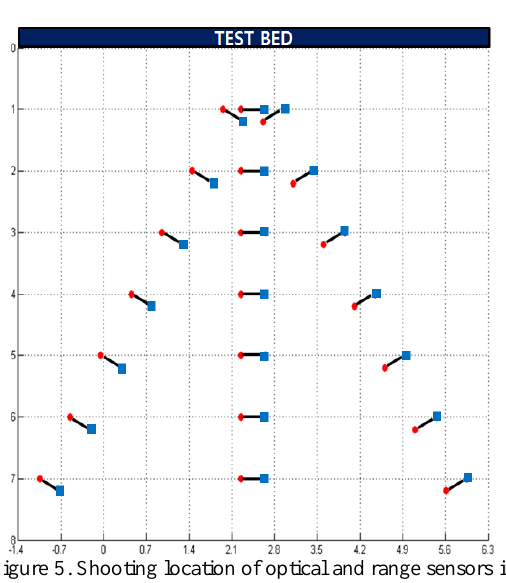
Figure 5. Shooting location of optical and range sensors in simulation (circles : optical sensor / squares: range sensor) IOP and Distortion parameters relate with each sensor, and these were pre-set as Table 3 and 4. In this study, optical and range sensors are fixed on a 0.4m-long frame, and the angle between the sensors was set at 6° in a counter- clockwise direction from the Y axis (Figure 6). ROP of range sensor can be calculated by plotting the location relationship between the cameras on optic-sensor coordinates (Table